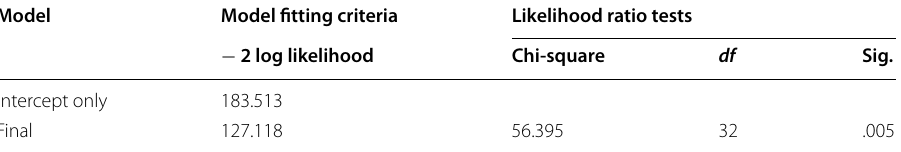
Table 4 Model fitting